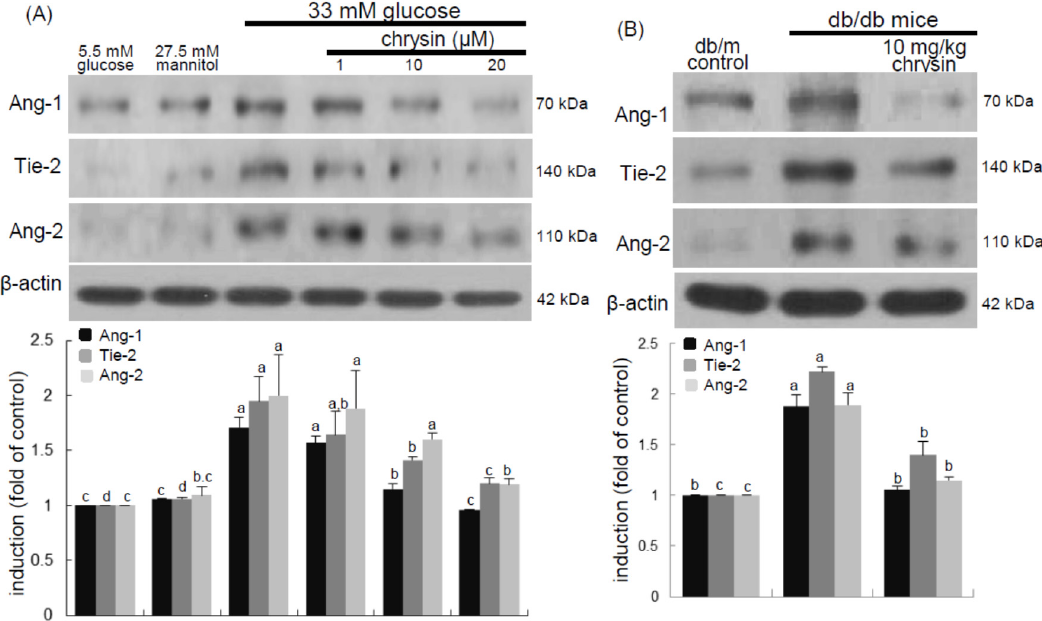
Figure 6. Inhibition of retinal induction of Ang-1, Ang-2, and Tie-2 by chrysin. HRMVEC were cultured in media of 33 mM glucose in the absence and presence of 1–20 μ M chrysin for two days ( A ). Cells were also incubated with 5.5 mM glucose and 27.5 mM mannitol as osmotic controls. The db/db mice were orally supplemented with 10 mg/kg chrysin daily for 10 weeks. The db/m mice were introduced as control animals ( B ). HRMVEC lysates and mouse retinal tissue extracts were subject Western blot analysis was conducted for the induction of Ang-1, Ang-2, and Tie-2 using a primary antibody against Ang-1, Ang-2, or Tie-2. β -Actin protein was used as an internal control. Bar graphs in the bottom panel represent densitometric results of upper blot bands. Values (means ± SEM, n = 3) not sharing a common letter differ, p < 0.05.